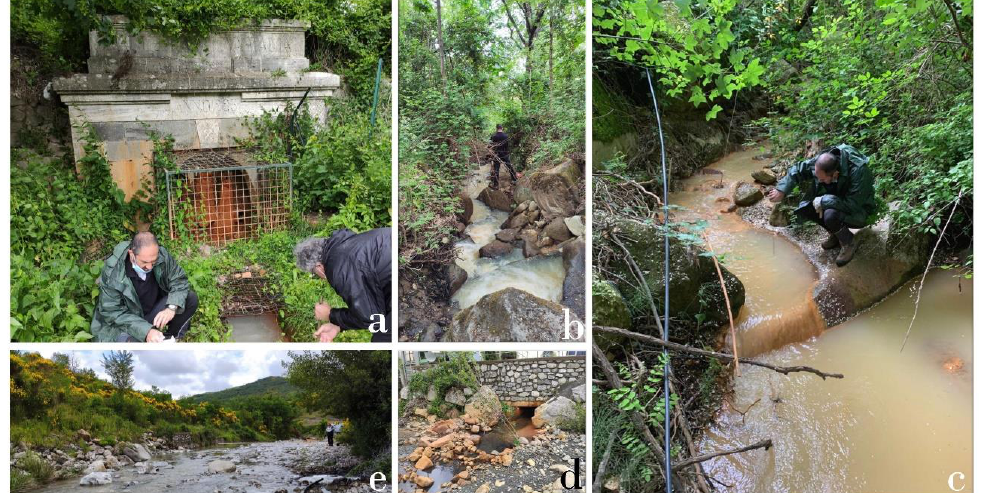
Figure 2. ( a ) Waters discharging from Galleria Italia (GIT0) feeding the Fosso della Chiusa creek. Note the whitish-reddish waters at the GIT0, GIT3 ( b ), a couple of hundreds meter from the emergence, and GIT6 ( c ), about 1 km from the emergence, sampling sites; ( d ) FdC waters entering the Pagliola creek after supplying the “La Turbina” hydroelectric plant; ( e ) the Pagliola creek after the confluence with FdC.